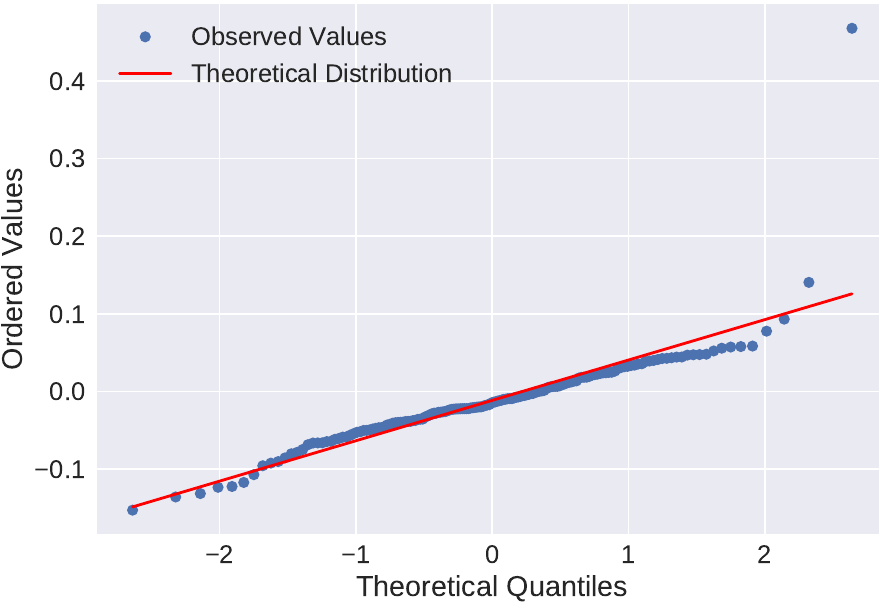
Figure 21. Variables distribution for 10% ≤ SMAPE <